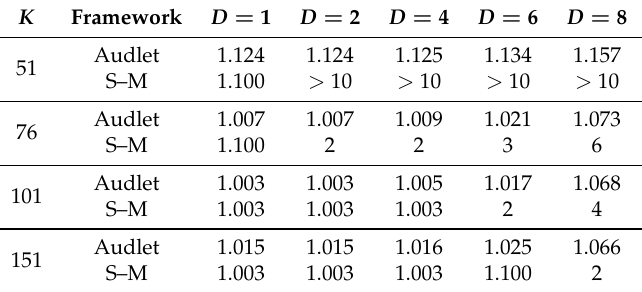
Table 1. Ratios B / A for various combinations of D and K obtained for the proposed Audlet framework and reported in [44] (S–M).